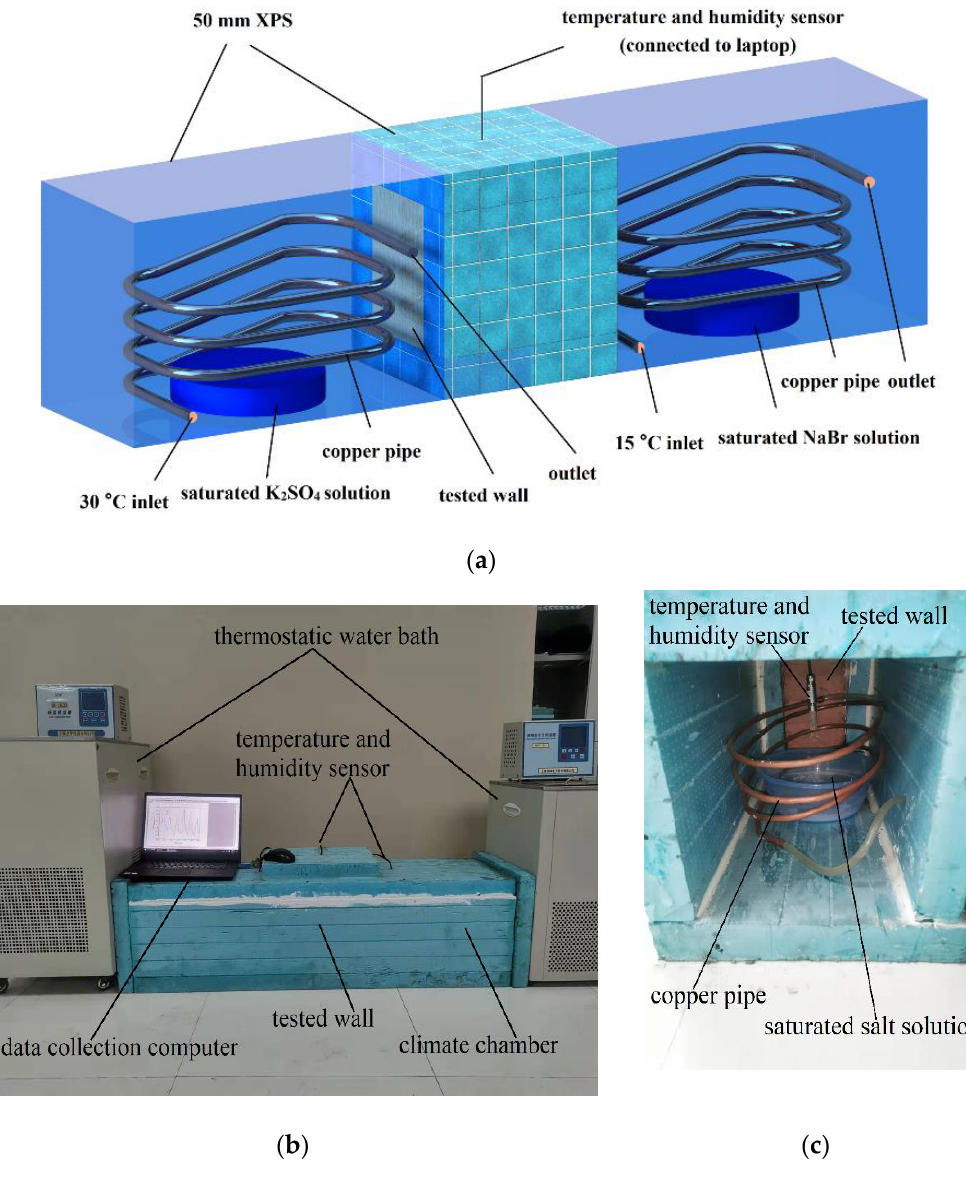
Figure 2. Experimental equipment for model validation: ( a ) perspective drawing; ( b ) experimental equipment system; ( c ) climate chamber on one side. Table 1. Saturated salt solutions used for obtaining different relative humidity at 25 ℃ .